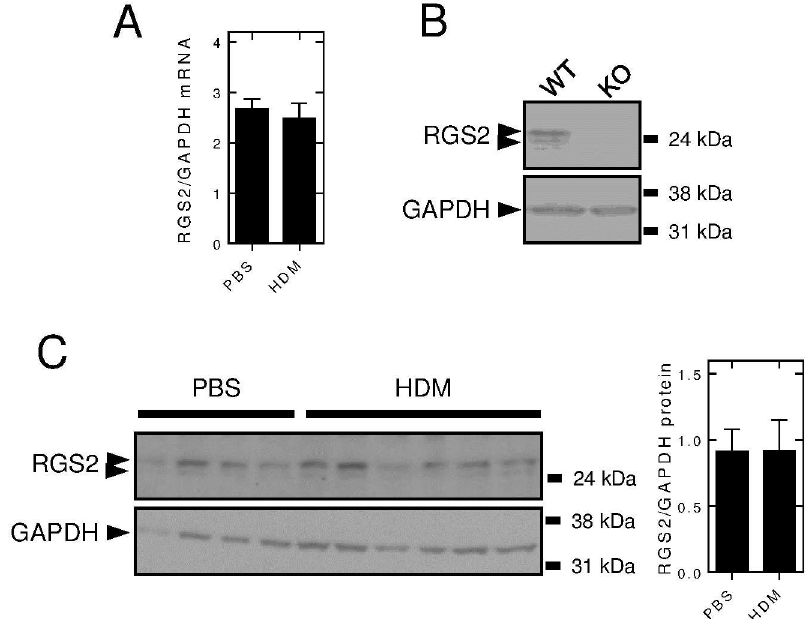
Fig 8. Effect of HDM instillation on Rgs2 mRNA and RGS2 protein expression. A, Wild type mice were subjectedto i . n . exposure with PBS or HDM (25 μ g) 3 times/week for 3 weeks. RNA was extracted from the right lungs and RGS2 and GAPDH mRNA expressionanalyzedby qPCR. Data ( N = 17 for PBS-exposed, N = 29 for HDM-exposed), normalized to GAPDH, are plotted as means ± SE. B, Total lung protein, prepared from wild type (WT) and Rgs2 -/- (KO) animals, was subjectedto western blot analysisfor RGS2 and GAPDH. Blots representativeof at least 10 independent animalsfor each genotypeare shown. C, Wild type mice were subjectedto i . n . treatment with PBS or HDM (25 μ g) 3 times/week and total lung proteins were subjectedto western blot analysisfor RGS2 and GAPDH. Data for 4 PBS and 6 HDM-exposed animalsare shown (left panel). Followingdensitometric analysisof these data, RGS2 expressionwas normalized to GAPDH and is plotted as mean ± SE (right panel). Protein size markers (kDa) are shown to the right of each